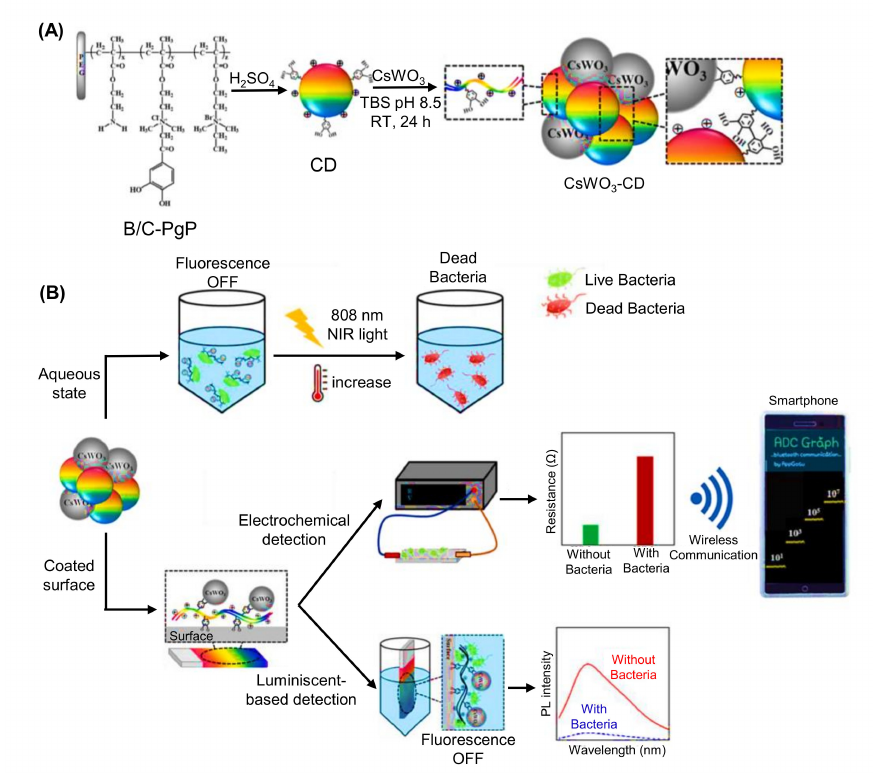
Figure 19. ( A ) Preparation of CsWO3-CD nanohybrids. ( B ) Scheme of luminescent-based and electrochemical sensor involving the use of CsWO 3 -CD nanohybrids to detect bacteria. Repro- duced from [263], with permission from Elsevier, 2020. B/C-PgP: bromoethane- and 2-chloro-3,4- dihydroxyacetophenone- quaternized poly ethylene glycol-grafted poly-2-(dimethylamino)ethyl methacrylate; TBS: Tris- buffered saline; RT: room temperature; NIR: near